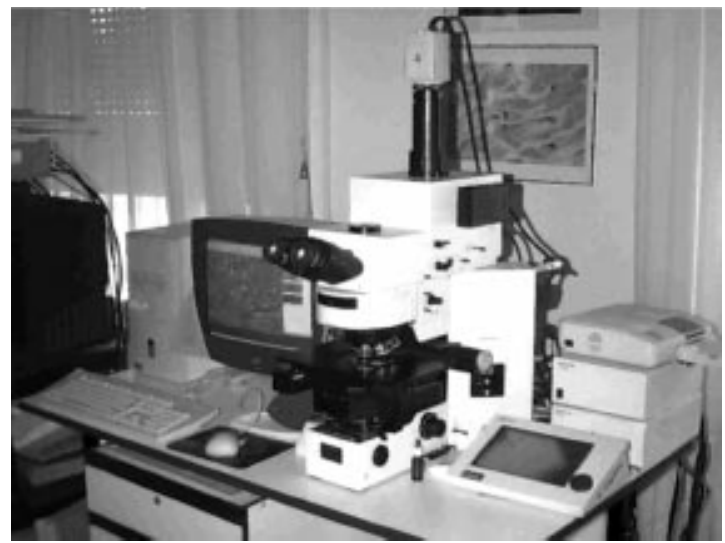
Fig. 1. The complete Migra telepathology